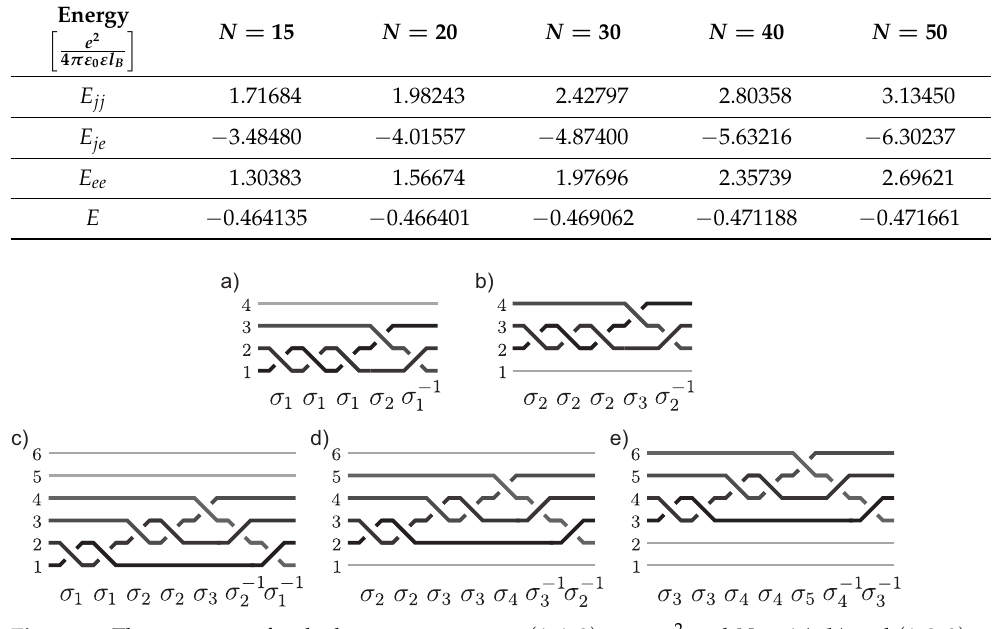
and N = 4 ( a , b ) and ( 1,2,3 ) at 5